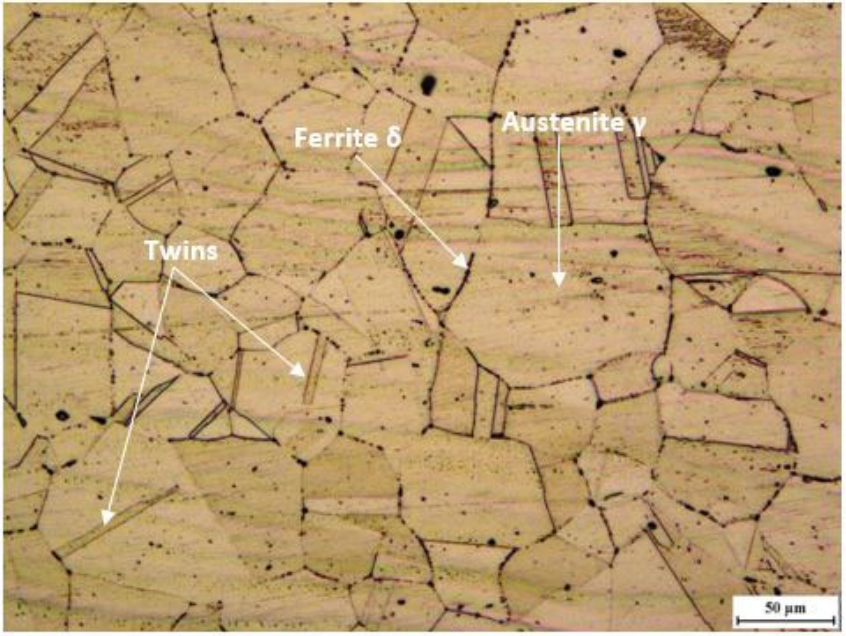
Figure 16. Optical micrograph of the base metal (BM) for the grade 304 austenitic stainless steel. As for Figure 17, it shows the microstructure of the HAZ of 304 austenitic stainless- steel. The structure subjected to the rolling process transforms into dendrite-like grains as the welding heat input increases towards the weld centerline. Consequently, the ZAT when approaching the fusion zone (FZ) suffers an increase in the austenitic grain size. Similarly, it is observed that a delta ferrite phase is not produced in that zone and that the annealing twins are formed more effectively